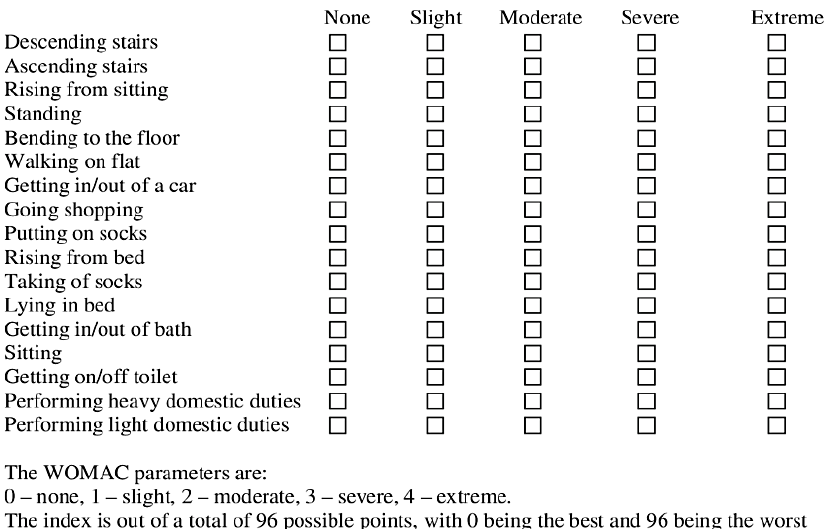
Figure 11. Western Ontario McMaster Osteo-Arthritis (WOMAC) scale/index indicating three parameters: pain, stiffness, and functional activities.